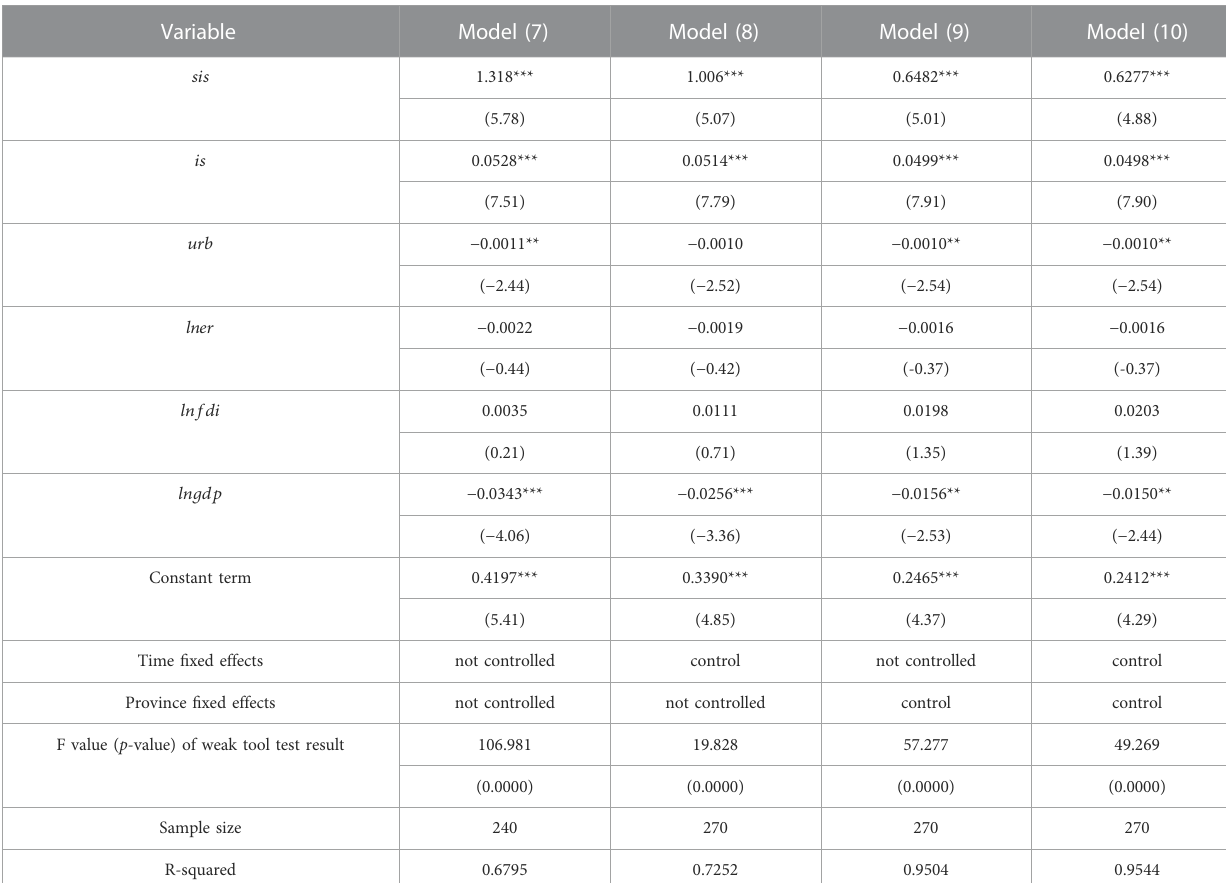
TABLE 5 Regression of instrumental